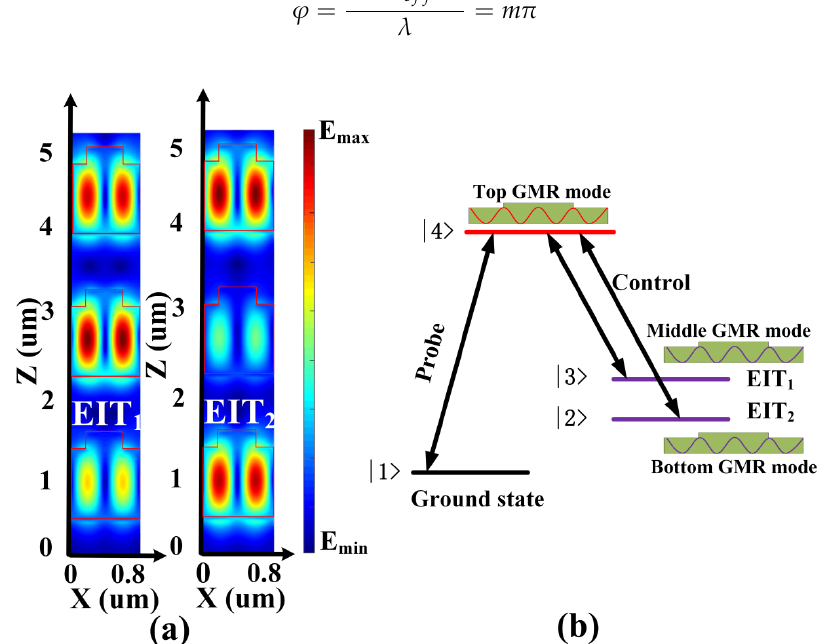
Figure 2. ( a ) Electric field distribution of two electromagnetically induced transparency (EIT) effects in the GMR system; ( b ) The analogy between the GMR system with a double EIT-like effect and a quasi- Λ four-level atomic system model.